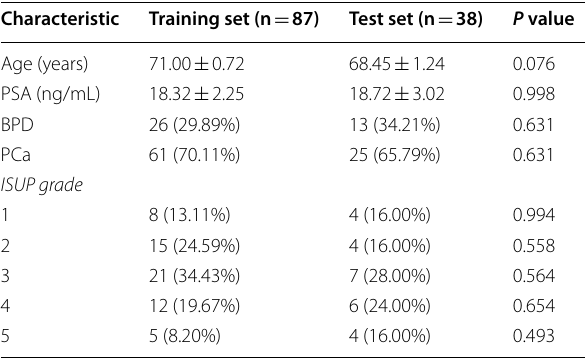
Table 1 Clinical characteristics in the training and test